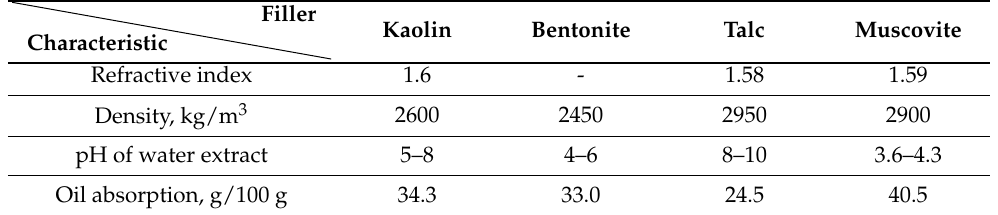
Table 1. Properties of used